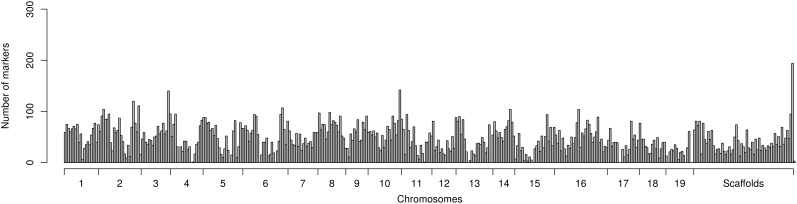
Distribution of markers mapped across the genome sequence of Salix purpurea genome available to the public. Each marker distribution bin encompasses 1 Mb of the genome sequence.